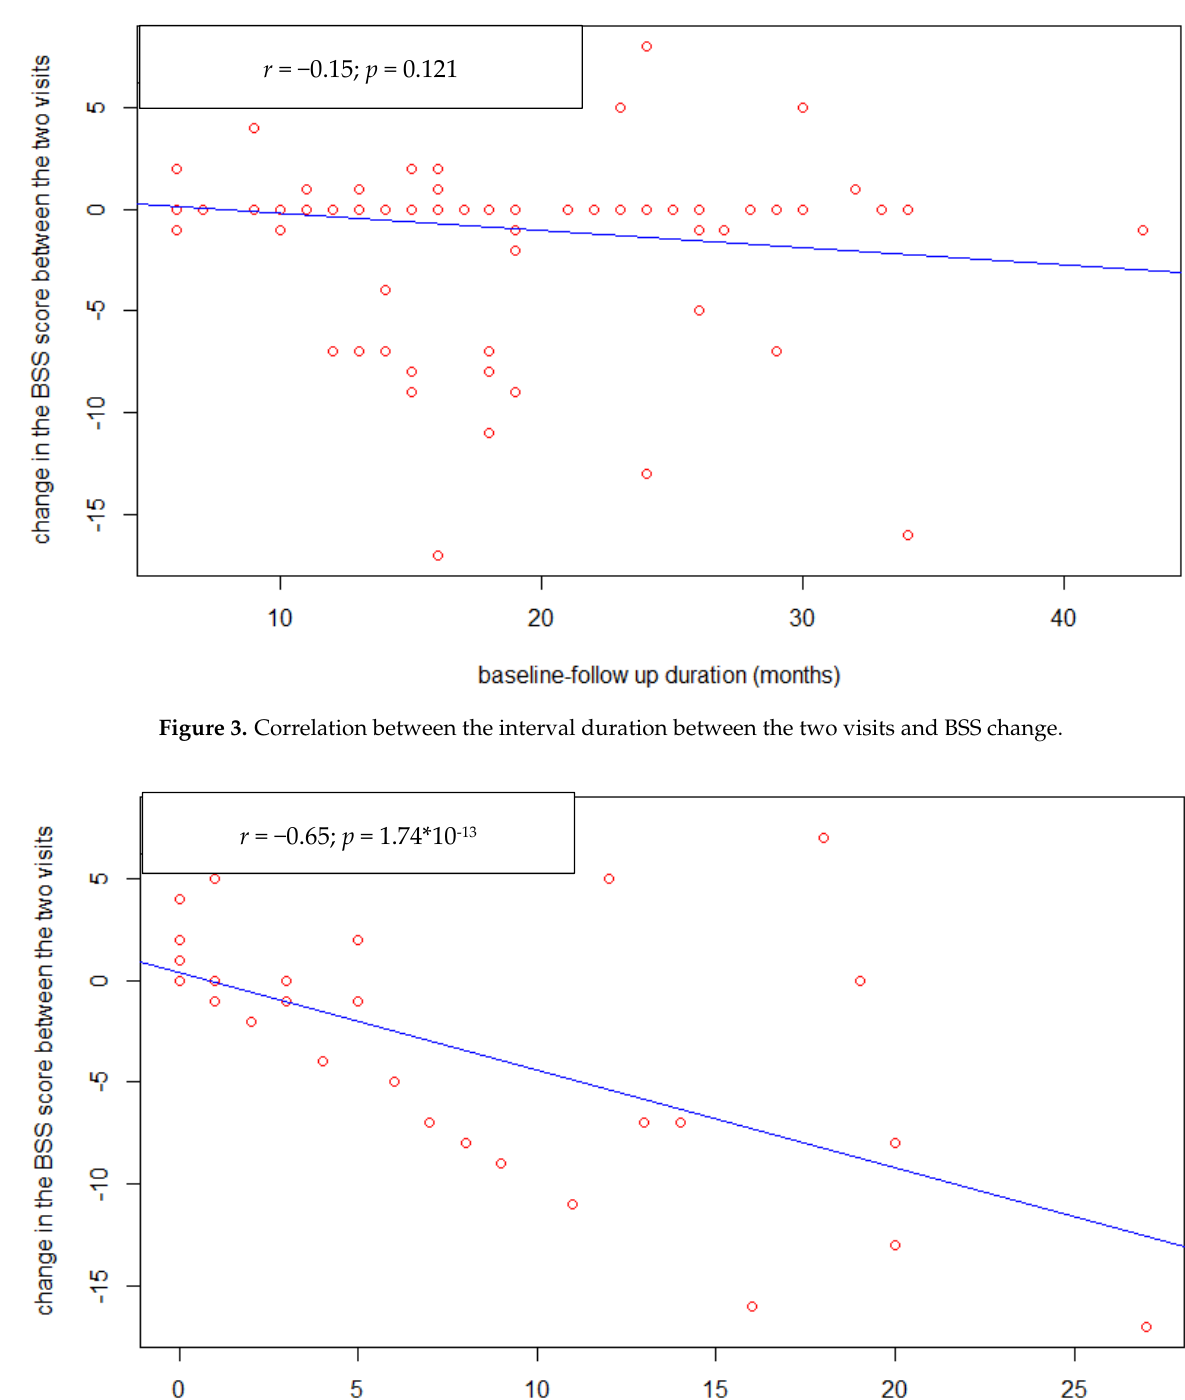
Figure 2. Correlation between BSS and chlorpromazine equivalent (CPZe) changes.